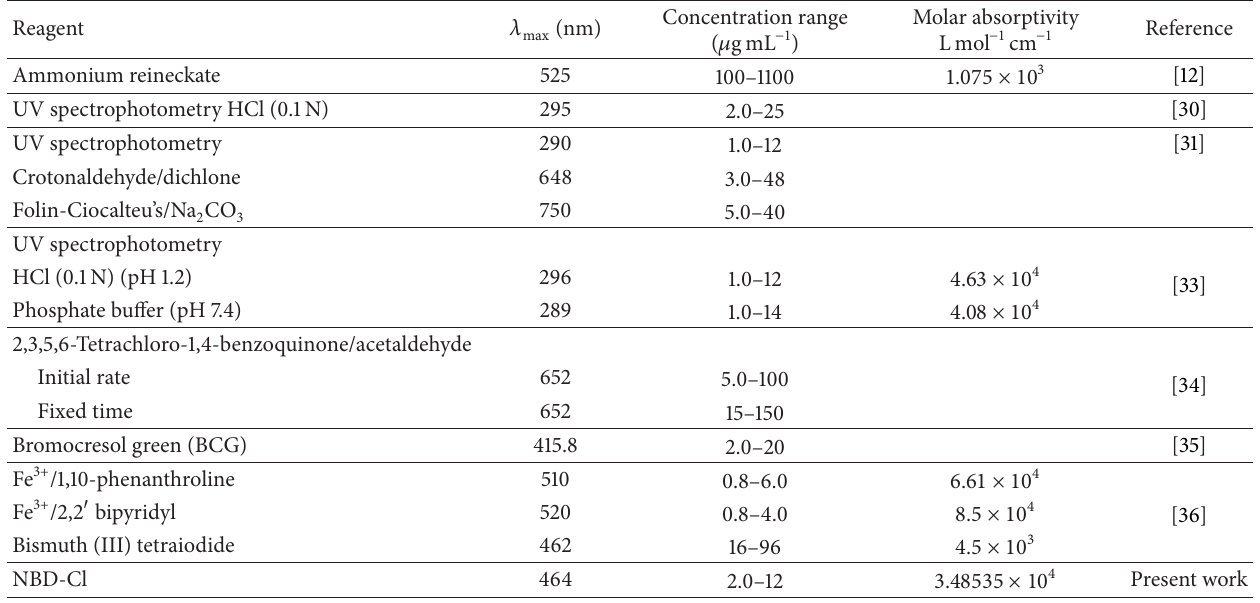
Table 2: Comparison between the previously mentioned spectrophotometric methods for determination of MOX.